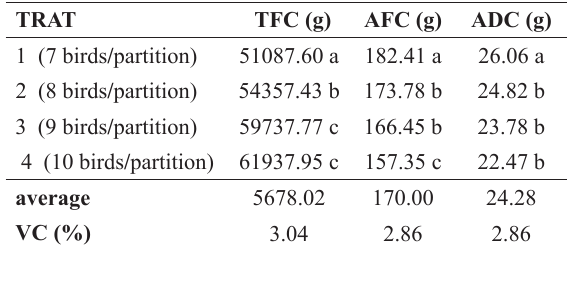
Density effects over the total feed consumption (TFC), average feed consumption per bird (AFC) and average daily bird consumption (ADC).